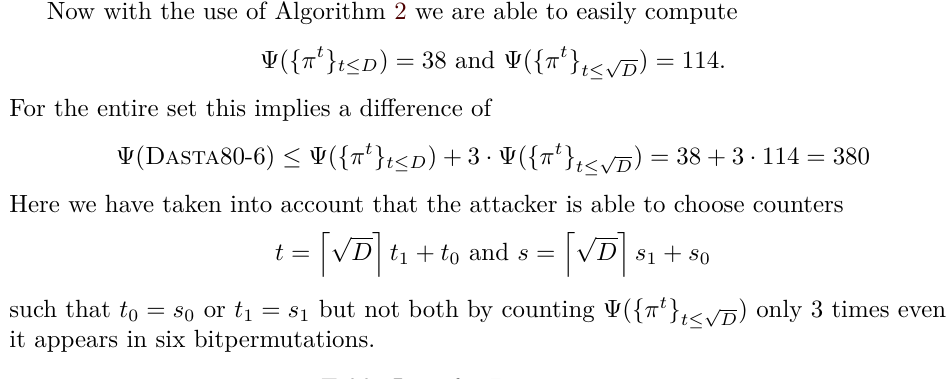
Table 5: Ψ for Dasta versions.